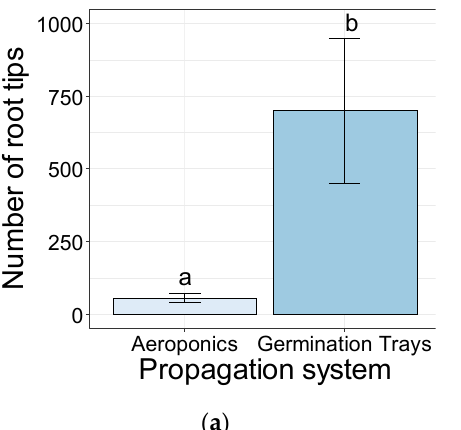
Figure 6. Root average diameter (cm) after 35 days of rooting of the softwood cuttings rooted in aeroponics systems and germination trays ( a ) and their root volume (cm 3 ) comparing propagation systems ( b ), backcross progenies ( c ), and K-IBA concentrations ( d ). Bars bearing the different letters are significantly different at p < 0.05.